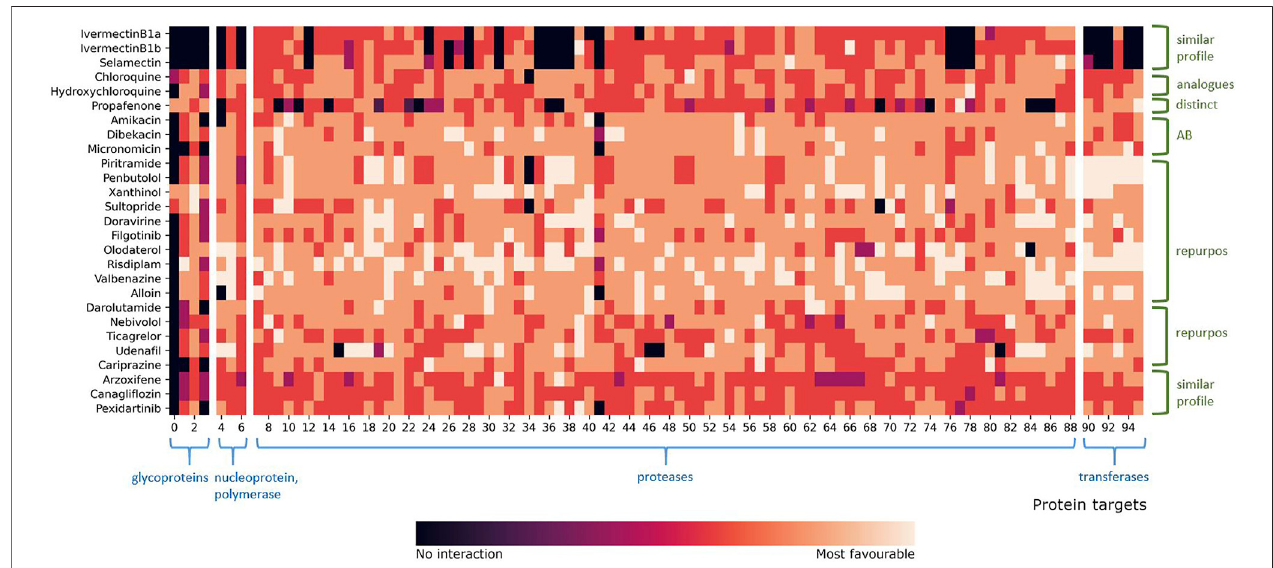
FIGURE 7 | Heatmap representation of compound fi ngerprints for the Coronaviridae database subset (836 proteins) for all compounds. The total number of combined targets is 96, and the list of PDB IDs is found in Supplementary Table S21 . The values shown in the heatmap were calculated and colored according to the normalizeddockingscoreforeachcompound.Interval0meansthatthecompounddidnotinteractwiththetarget,whileinterval5meansthatthecompoundhadamost favorabledockingscore.Proteintargetsaregroupedaccordingtotheirclassandclassesemphasizedinbluecolor.Fingerprintpro fi lesimilaritiesarecoloredgreen. Two “ repurpose ” subsets represent two different fi ngerprint pro fi les within the repurpose compounds group.